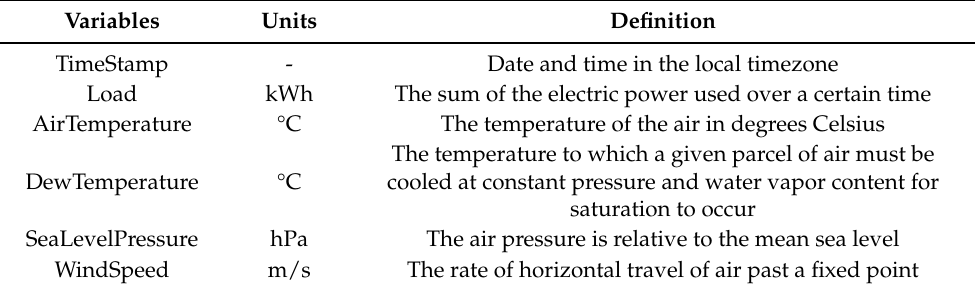
Figure 5. Power load for the four buildings. ( a ) Building A; ( b ) building B; ( c ) building C; ( d ) building D. Table 2. The Dataset Variables of Model